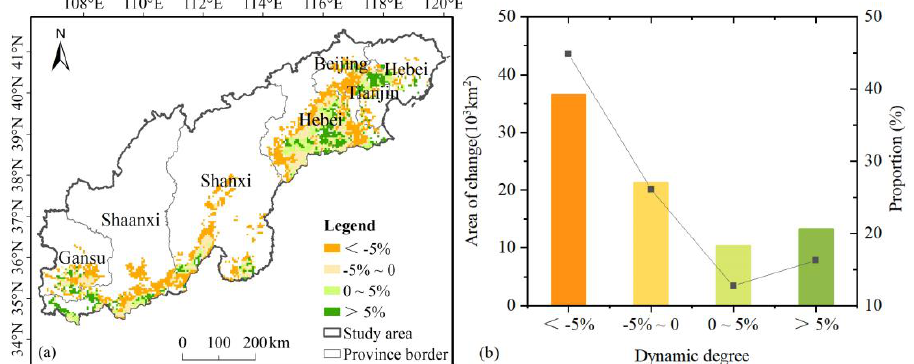
Figure 7. Dynamic degree analysis of spatial and temporal changes of winter wheat planting area from 2001 to 2019. ( a ) The dynamic degree of the winter wheat planting area changes in a 5 × 5-km grid; ( b ) The change area and proportion of winter wheat dynamic degree in a 5 × 5-km grid. (Dark orange is < − 5% dynamic degree, orange is − 5~0% dynamic degree, light green is 0~5% dynamic degree, green is > 5% dynamic degree.).